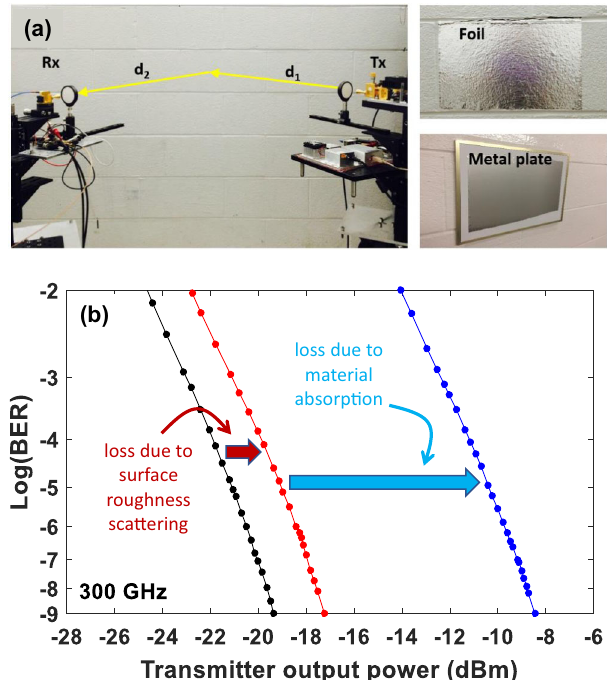
Fig. 2 | Links employing specular re fl ection. Measured bit error rate (BER) for a 2-mlinkwhichincorporatesaspecularre fl ectionfromacinderblockwall,asshown in the top left photo. The effects of absorption and scattering are separated by measuring the link on the bare wall (blue points), the same wall with a conformal metalfoilcoatingthateliminatespenetrationintothecinderblock(redpoints),and a fl at metal plate which eliminates both absorption and scattering (black points). The photo images in ( a ) depict the three situations corresponding to the mea- surementsin( b ).ReprintedfromMa,J.,Shrestha,R.,Moeller,L.&Mittleman,D.M.; Channel performance of indoor and outdoor terahertz wireless links. APL Photon. 3, 051601 (2018)., with the permission of AIP